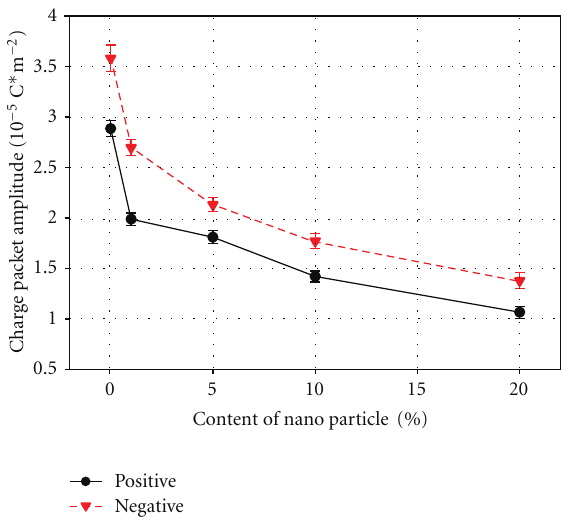
Figure 12: Charge pulse amplitude for pure epoxy resin and epoxy- based nanocomposites (90% confidence